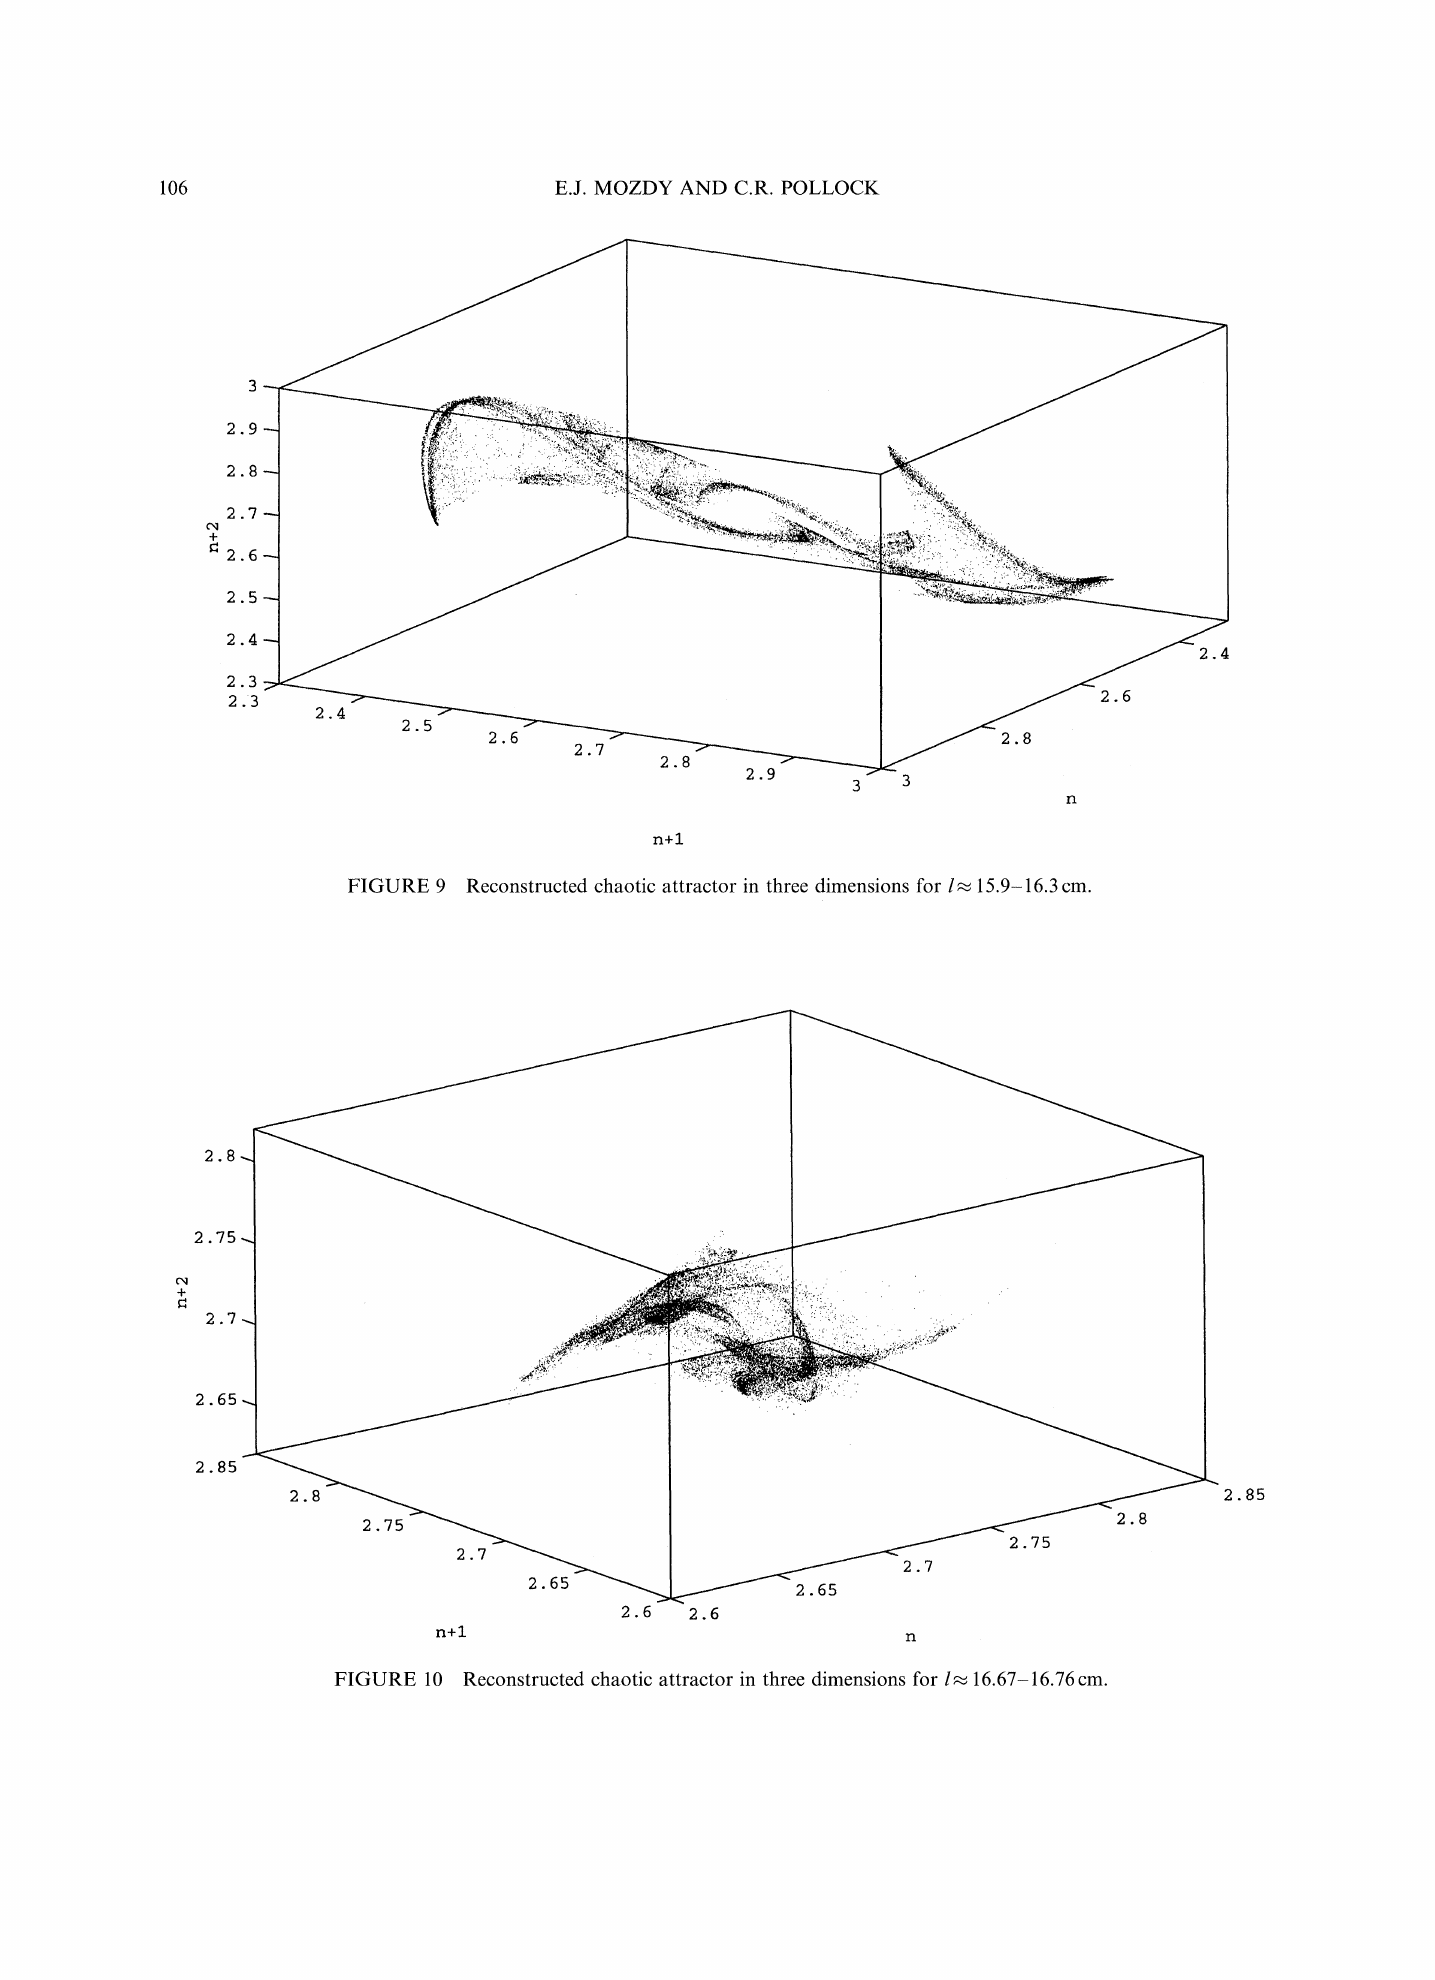
FIGURE 9 Reconstructed chaotic attractor in three dimensions for l 15.9-16.3 cm.